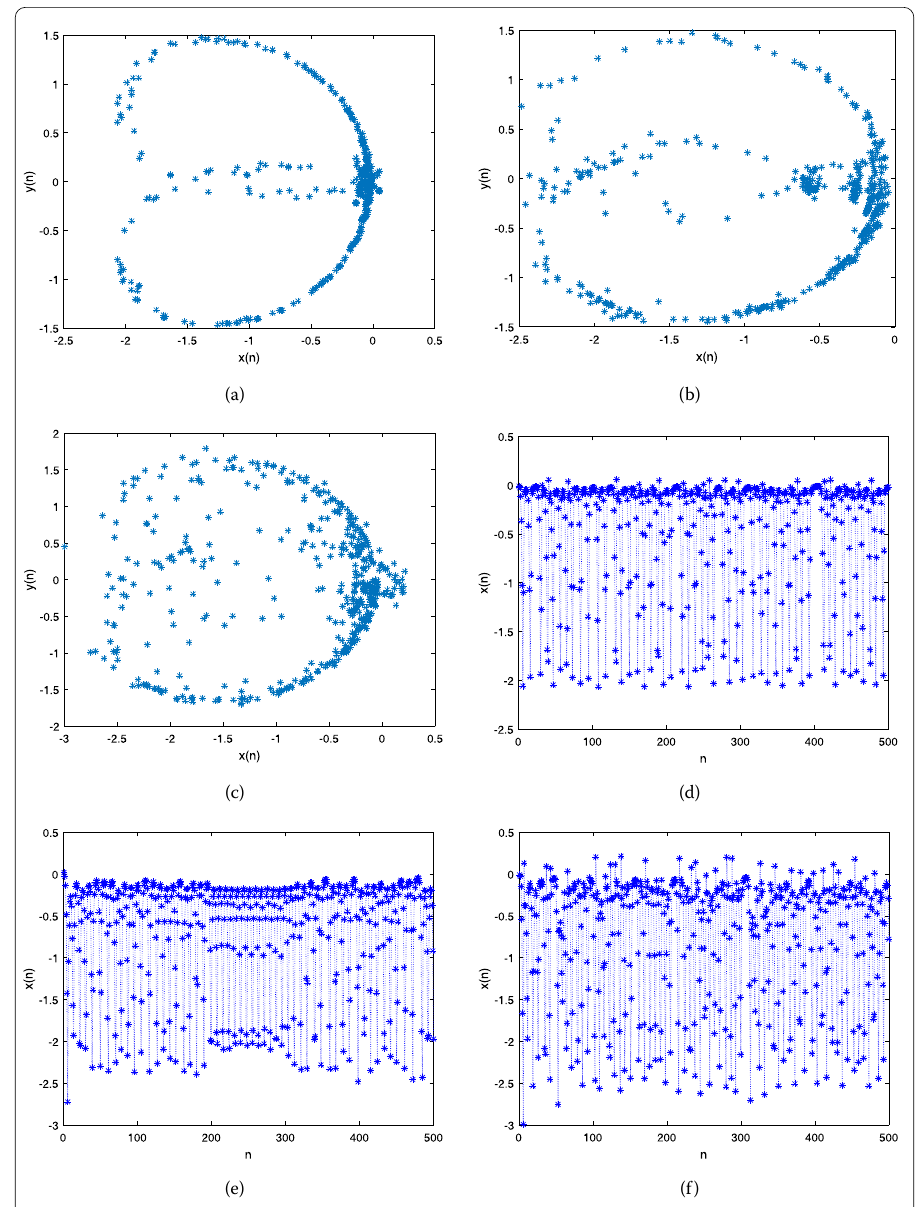
Figure 6 The phase portraits and chaotic solutions. The phase portraits of system (10) for ( a ) a = 1, b = 0.85 and v = 0.9, ( b ) a = 0.7, b = 0.9 and v = 0.9, ( c ) a = 1, b = 1 and v = 0.85, respectively. The chaotic solutions of system (10) for ( d ) a = 1, b = 0.85 and v = 0.9, ( e ) a = 0.7, b = 0.9 and v = 0.9, ( f ) a = 1, b = 1 and v = 0.85,